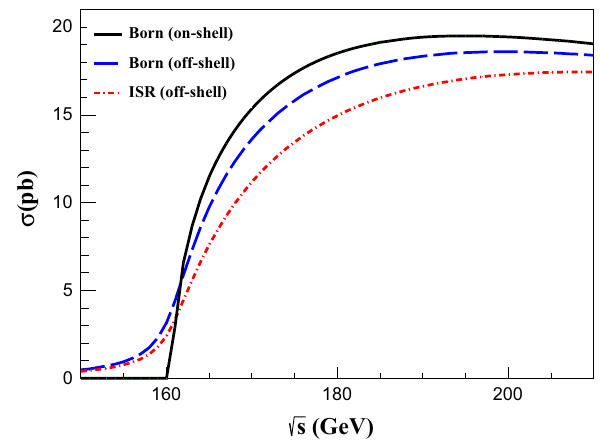
Fig. 2 Thetheoreticalcrosssectionsof W -pairproductionasfunctions oftheCMenergyofthe e + e − collisions.TheblacksolidlineistheBorn- level cross section with the zero-width assumption, the blue dash line is the Born-level cross section including the finite width of the W boson. The red dash-dot line is the cross section taking into account both the finite width of the W boson and the ISR corrections. The world average values [15] of m W and Γ W are used in these calculations with ν e , γ , and Z , propagators, respectively; Δσ = σ − ¯ σ ;